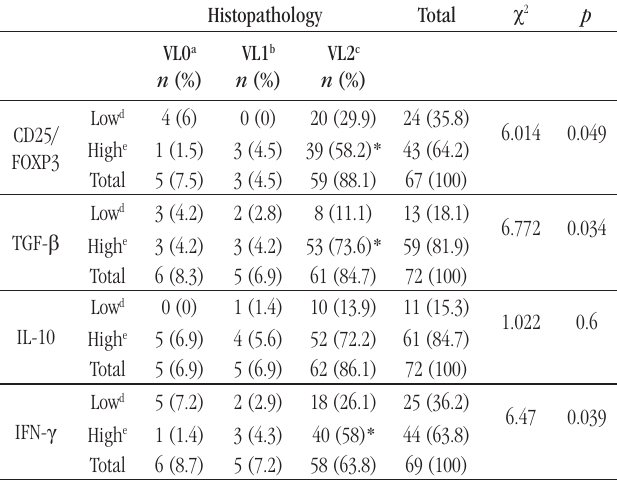
taBLE 4 − Distribution of viral load according to the intensity of expression of CD25/FOXP3, TGF- β , IL-10 and IFN- γ